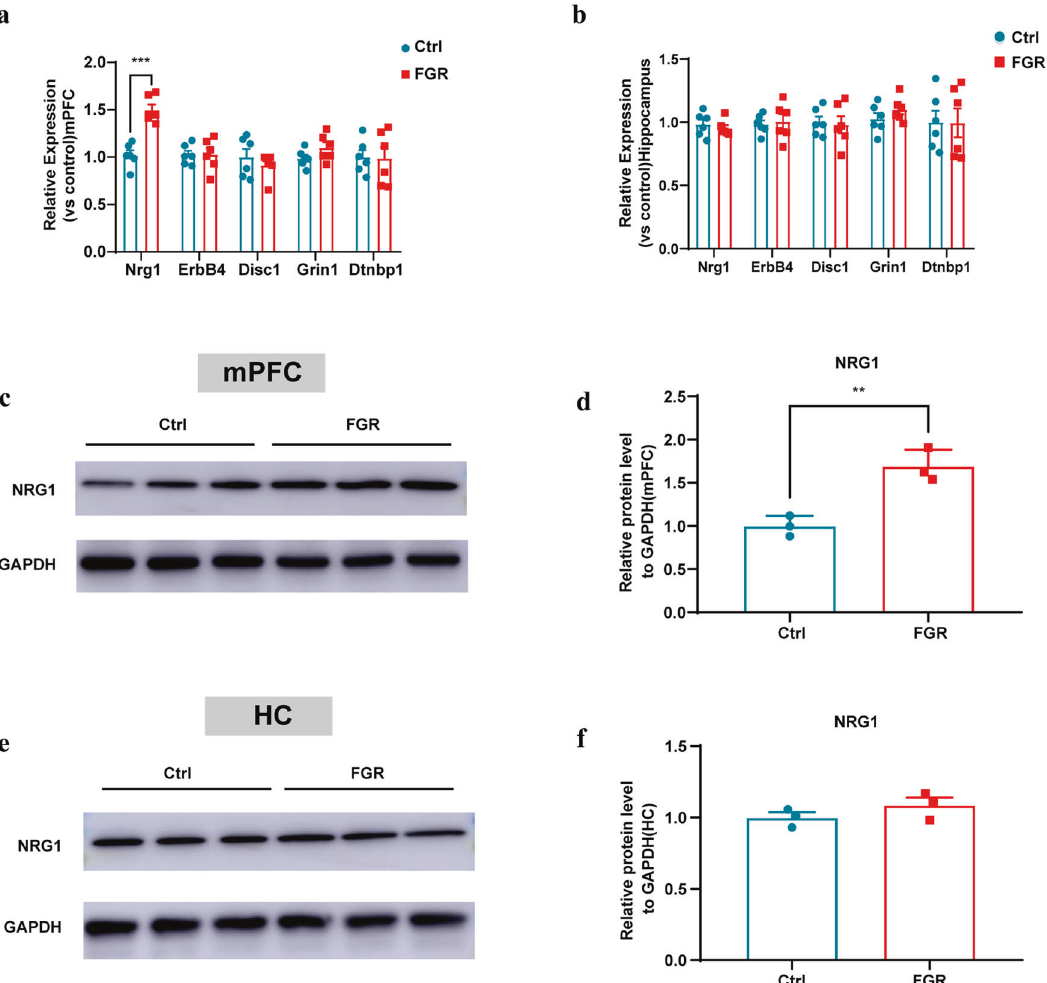
Fig. 3 FGR leads to upregulation of Nrg1 in mPFC. a Nrg1, ErbB4, Disc1, Grin1 and Dtnbp1 mRNA levels in the mPFC of control ( n = 6) and FGR ( n = 6) mice. Nrg1: unpaired t test, P < 0.001. ErbB4: unpaired t test, P = 0.982. Disc1: unpaired t test, P = 0.423. Grin1: unpaired t test, P = 0.134. Dtnbp1: unpaired t test, P = 0.925. b Nrg1, ErbB4, Disc1, Grin1 and Dtnbp1 mRNA levels in the hippocampus of control ( n = 6) and FGR ( n = 6) mice. Nrg1: unpaired t test, P = 0.528. ErbB4: unpaired t test, P = 0.755. Disc1: unpaired t test, P = 0.809. Grin1: unpaired t test, P = 0.252. Dtnbp1: unpaired t test, P = 0.973. c , d Representative blots and statistical analysis of NRG1 protein in the mPFC from control and FGR mice. e , f Representative blots and statistical analysis of NRG1 protein in the hippocampus from control and FGR mice. The results are expressed as mean ± SD.; * P < 0.05, ** P < 0.01, and *** P <